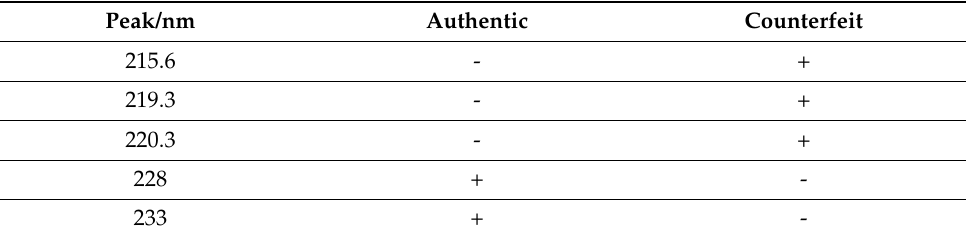
sent in the counterfeit (and vice versa).